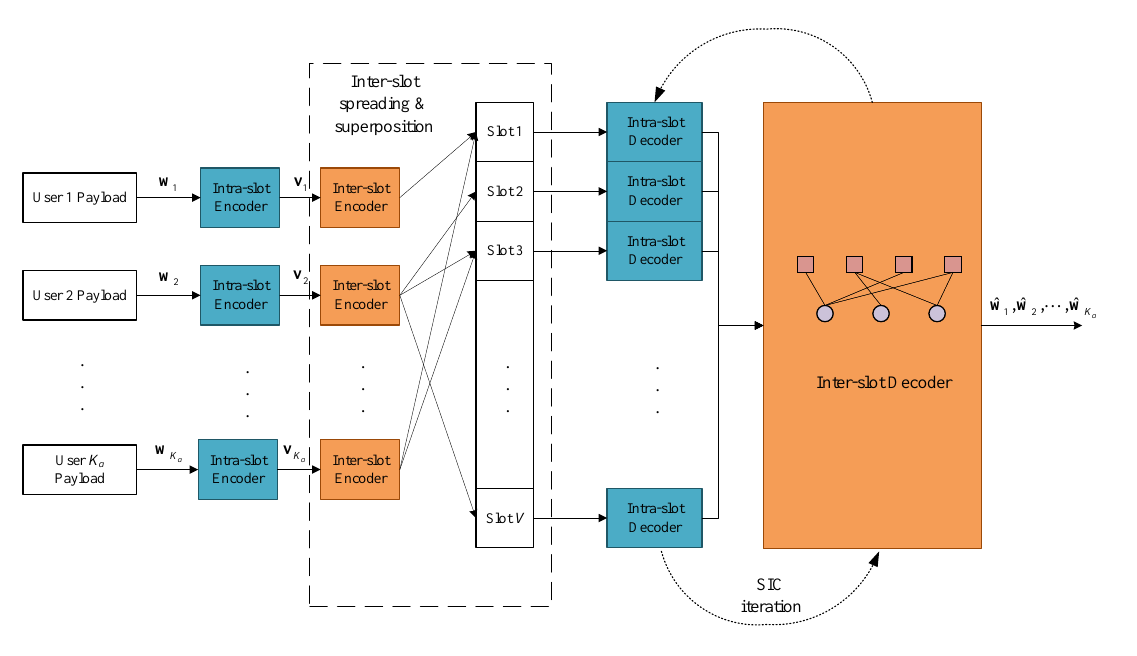
Figure 1. The overall system framework of the proposed scheme.